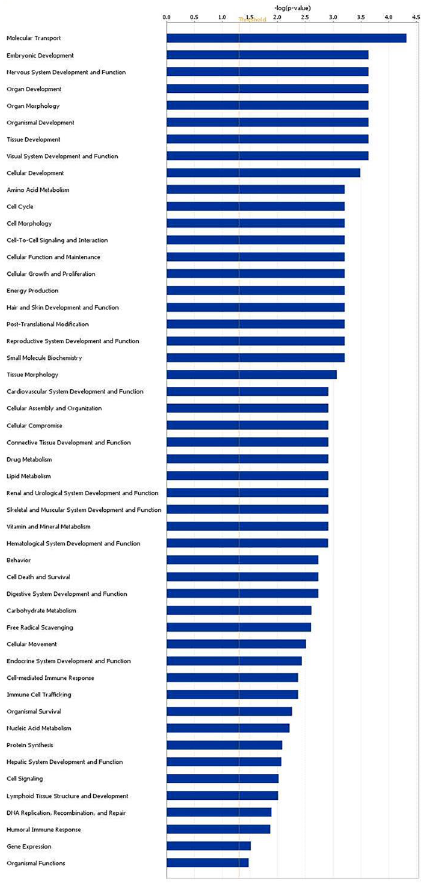
Figure 1. Top functions of genes differentially expressed in bull testes at 12 weeks as per Ingenuity Pathway Analysis (IPA) (Top 25 functions shown). Functions are marked on the X-axis and -log (p value) marked on the Y-axis. Right-tailed Fisher’s exact test was used to calculate the p-value determining the probability that each biological function assigned to that data set is due to chance alone (P < 0.05). This image was generated through the use of IPA (QIAGEN Inc., https:// www. qiage nbio- infor matics. com/ produ cts/ ingen uity- pathw ay- analy sis) 15